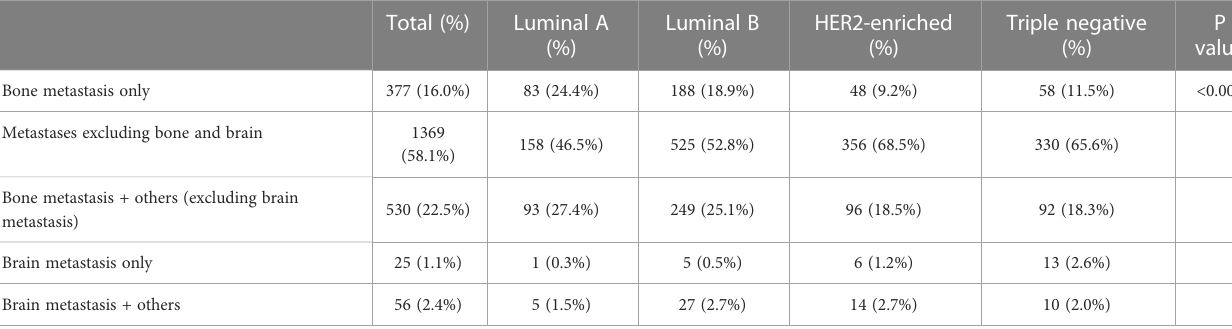
TABLE 2 Pattern of distant metastasis according to molecular subtypes.